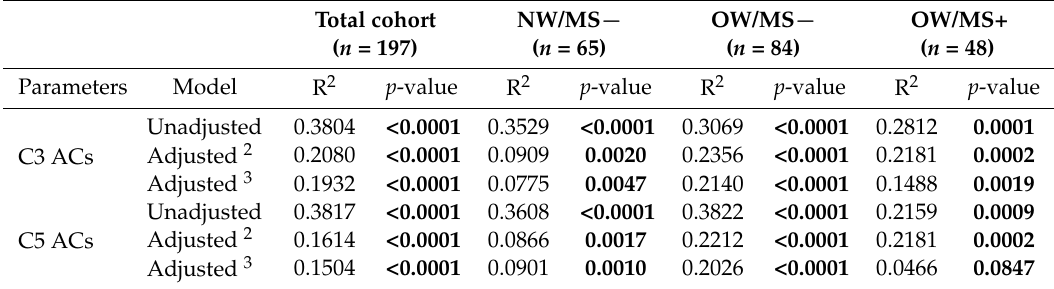
Figure 2. Mean plasma concentrations of C3 and C5 ACs in relation with mean plasma BCAA levels between subgroups of NW/OW individual with or without MS. Plasma BCAA levels are shown in salmon; C3 ACs are shown in dotted light orange; C5 ACs are shown in striped medium orange. Whiskers represent standard error. Values presented are unadjusted. All mean values are significantly different ( p < 0.05) between groups. Table 5. Associations between plasma BCAA and C3 and C5 ACs plasma levels in the whole cohort and by subgroups based on OW and MS status without and with adjustments for confounders. All lines were computed